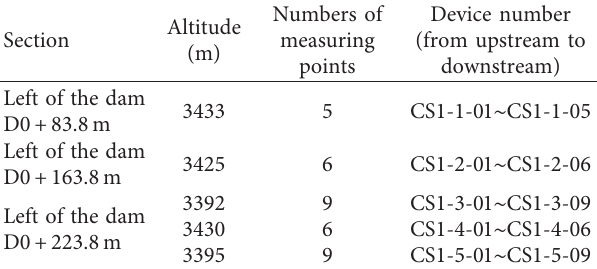
Table 2: The arrangement of extensometers.